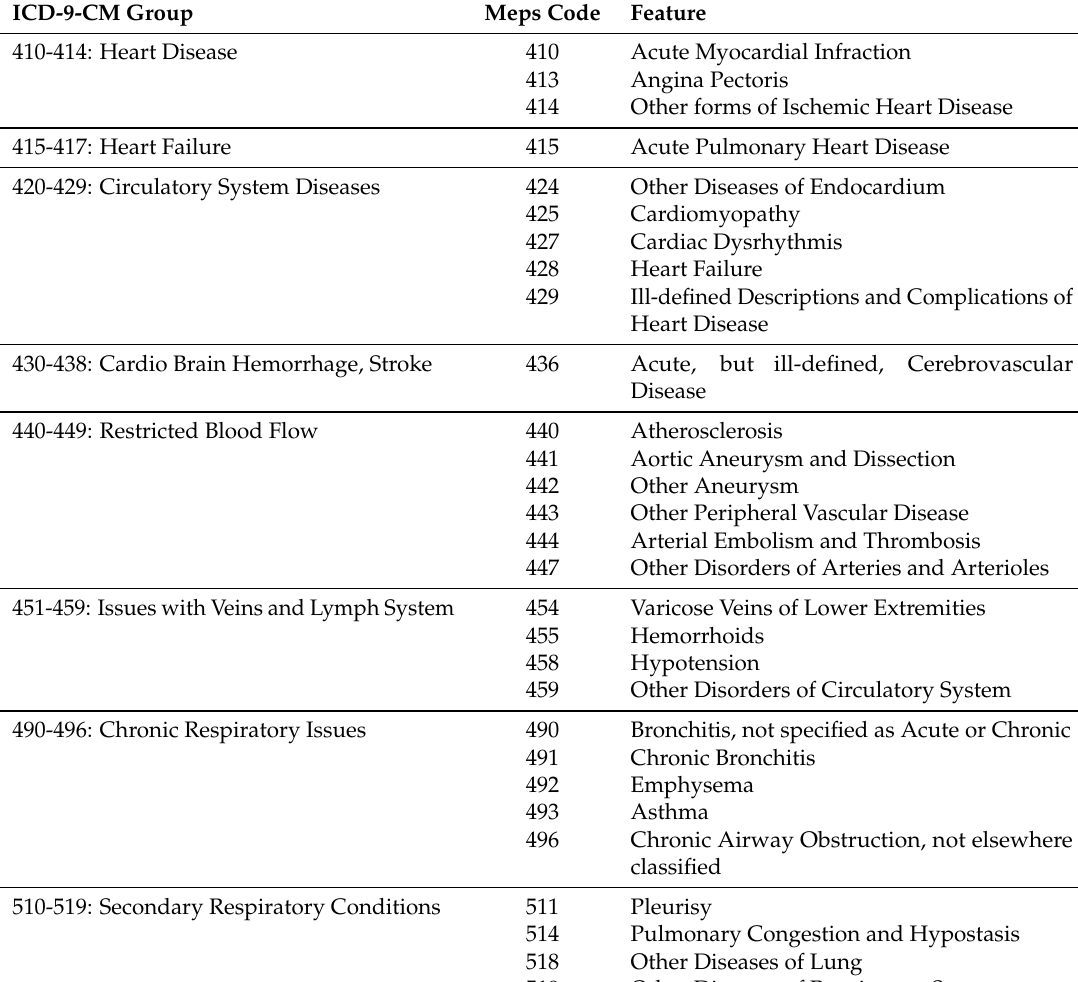
Table 1. Selected Pre-exiting